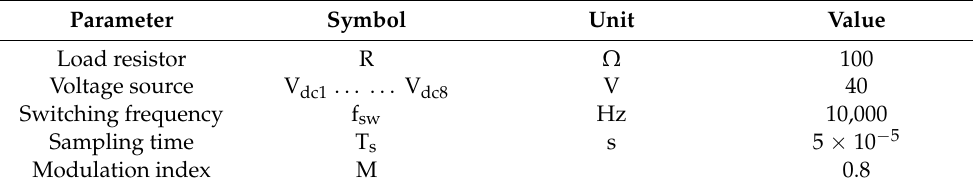
Table 11. Parameters of five-level DC/AC converter with algorithm DSA-LSC.